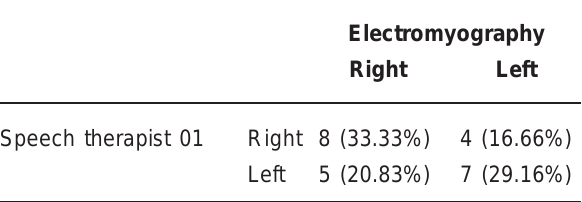
TABLE 1- Agreement between palpation of speech therapist 01 and EMG